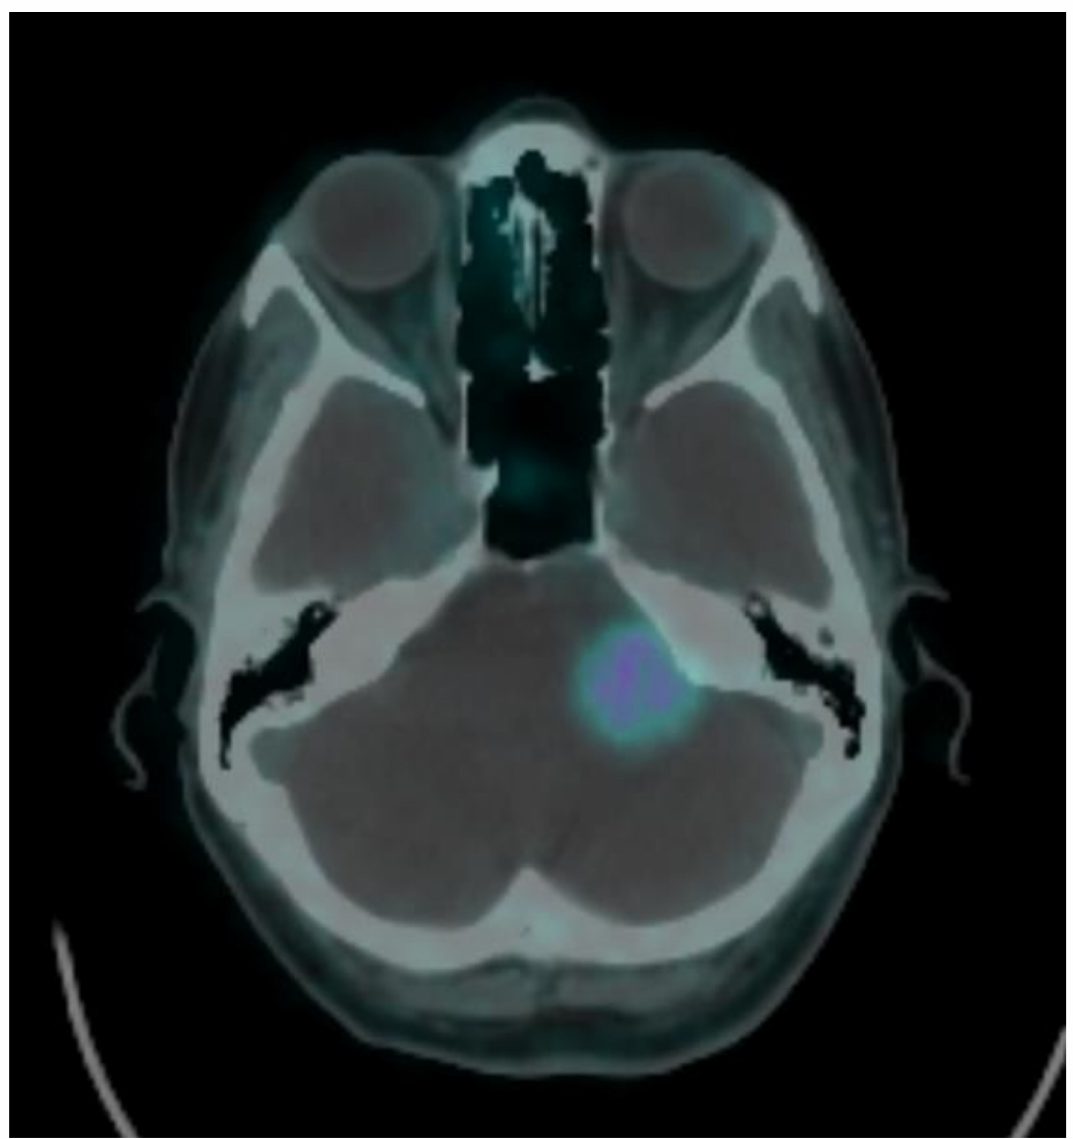
Figure 3. 68 Ga-DOTATOC PET/CT follow up at 6 months showing SUV intensity and reduction of the lesion from 7.1 to 4.1